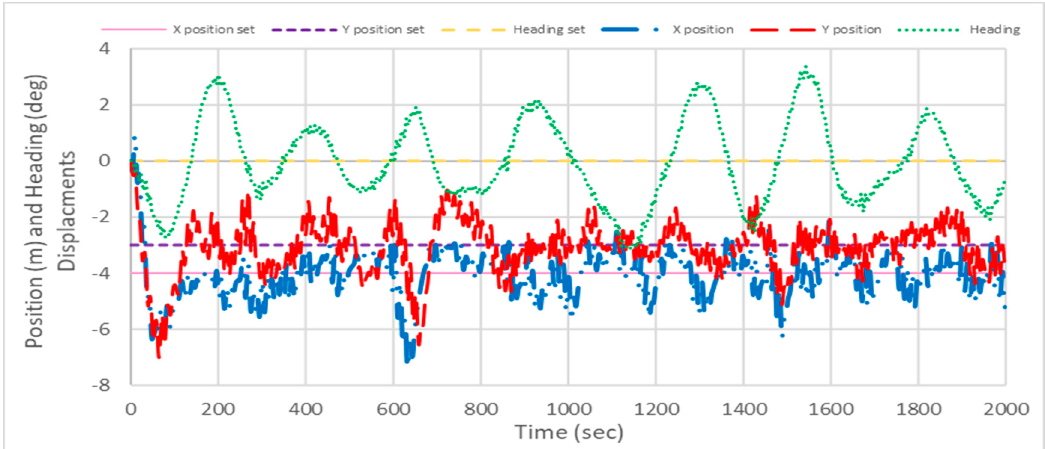
Figure 12. DP simulation with PID control showing platform X, Y position and heading angle.